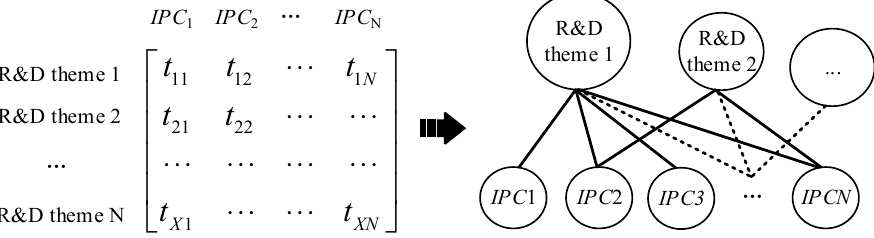
Figure 7. Network analysis using based on IPC nodes and R&D theme nodes.